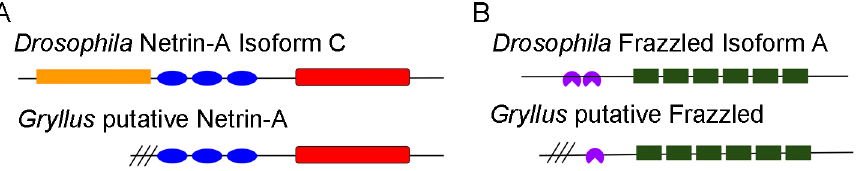
Fig 3. Netrin and Frazzled proteins in Drosophila and G . bimaculatus share most domains. A) The type, number, and order of protein domains was assessed by using Drosophila Netrin A, isoform C (AHN59713) and the putative G . bimaculatus Netrin A (TRINITY_DN160784_c2_g1_i2) as queries in a conserved domain search. Drosophila Netrin A, isoform C possessed a laminin N-terminal domain (yellow rectangle), three laminin-type EGF-like domains (blue ovals), and a netrin-like domain (red rectangle). The angled lines on the G . bimaculatus protein representation indicate missing N-terminal sequence, but the remaining sequence matches that of Drosophila , with three laminin-type EGF- like domains (blue ovals), and a netrin-like domain (red rectangle). B) The type, number and order of protein domains in Drosophila Frazzled, isoform A (AAF58493) and the putative G . bimaculatus Frazzled (TRINITY_DN172587_c0_ g1_i7) was assessed using a conserved domain search. Frazzled had at-least two Ig-like domains (purple) and 6 Fibronectin Type III domains. The predicted G . bimaculatus protein was similar, though some sequence was missing from the N-terminal end (angled